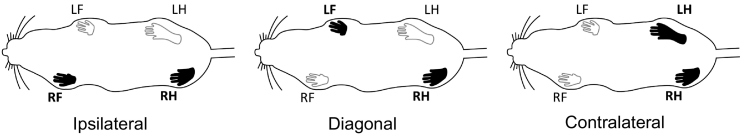
Schematic of the ipsilateral (RF-RH), diagonal (LF-RH), and contralateral (LH-RH) phase dispersions used for gait analysis. Relevant limbs relative to the LDF limb (RH) shaded in black. L = left, R = right, F = forelimb, H = hindlimb.